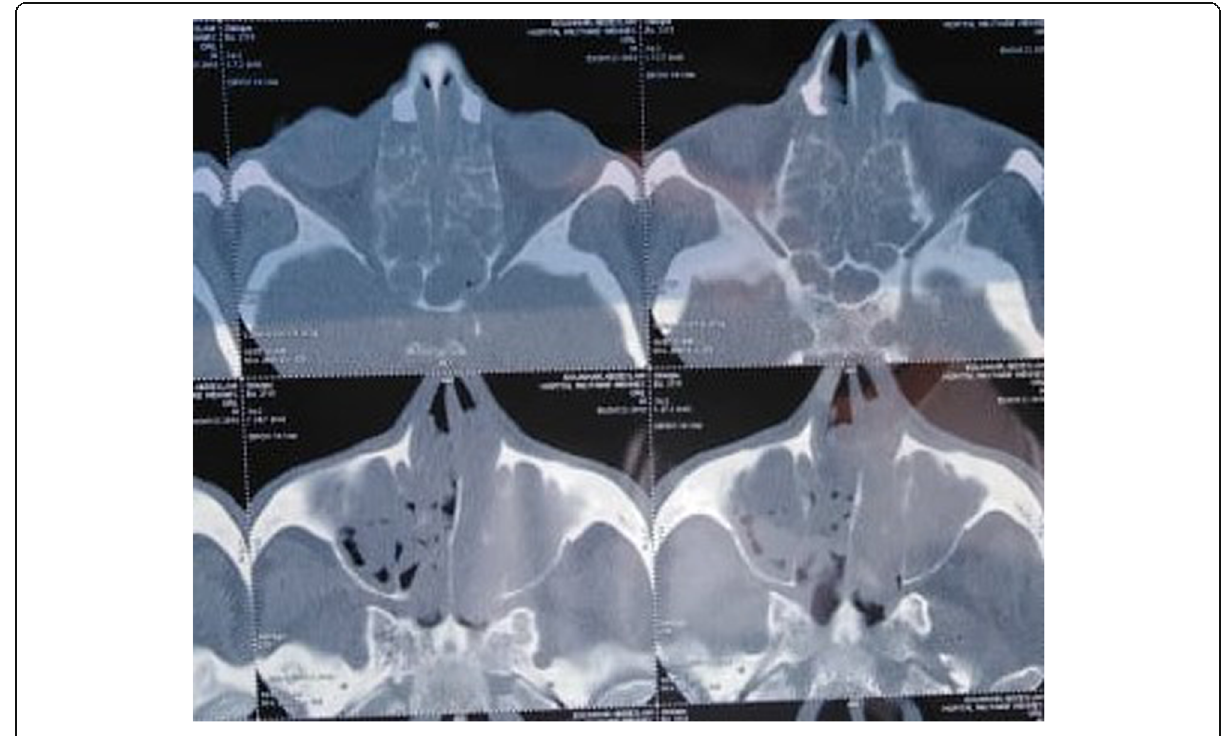
Fig. 2 Sinus axial CT scan sections of sinus cavities